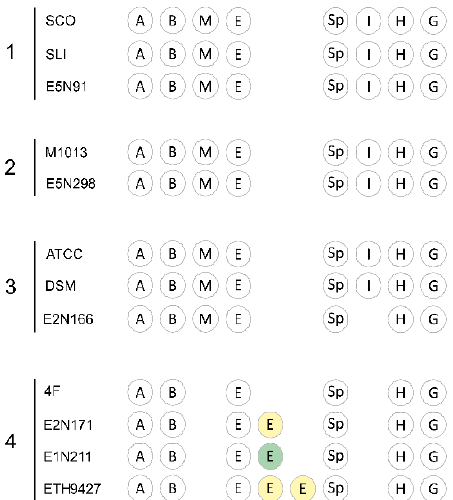
5 of 11 Figure 2. Specialized metabolite biosynthetic gene clusters identified in analyzed strains. Genome sequences were analyz ed with antiSMASH 3.0 for gene cluster identification. The “Hybrid” category